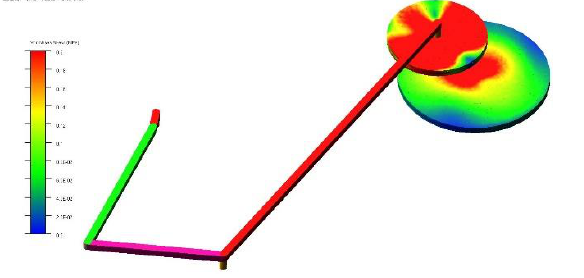
Fig. 5. MBS model of the polishing mechanism.